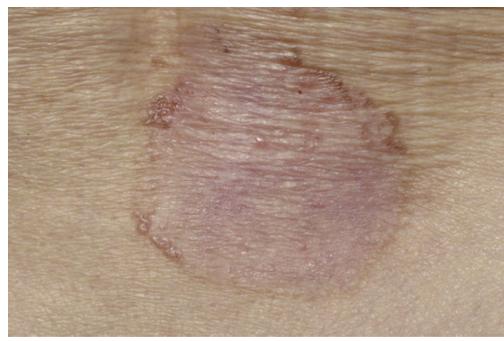
Figure 2: Superficial BCC. Table 1: Factors associated with high risk of future BCC